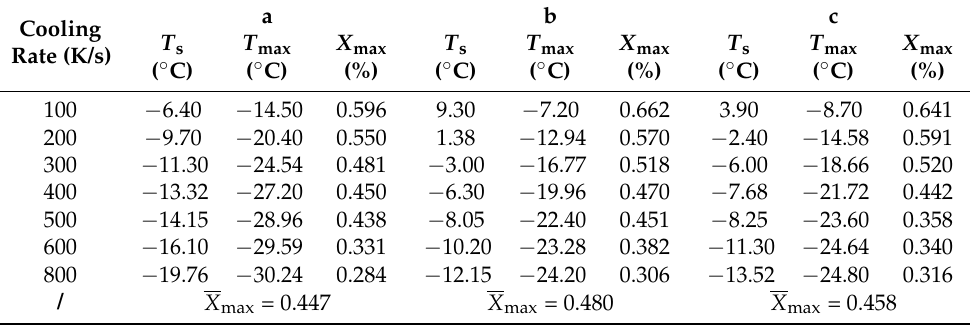
Table 1. Characteristic parameters of PEG and PEG-PLLA during the non-isothermal